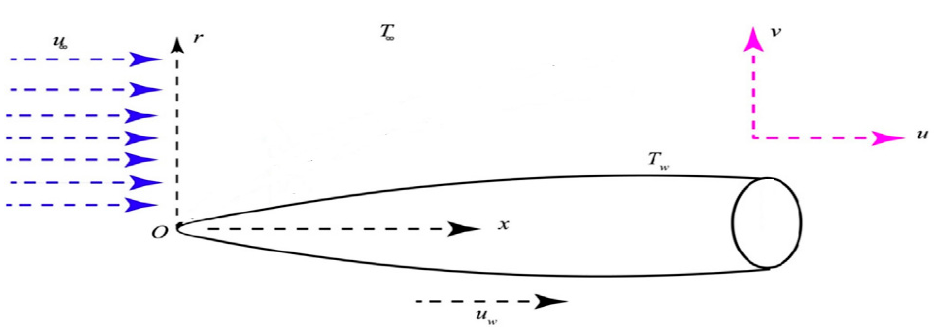
Figure 1. Flow model.